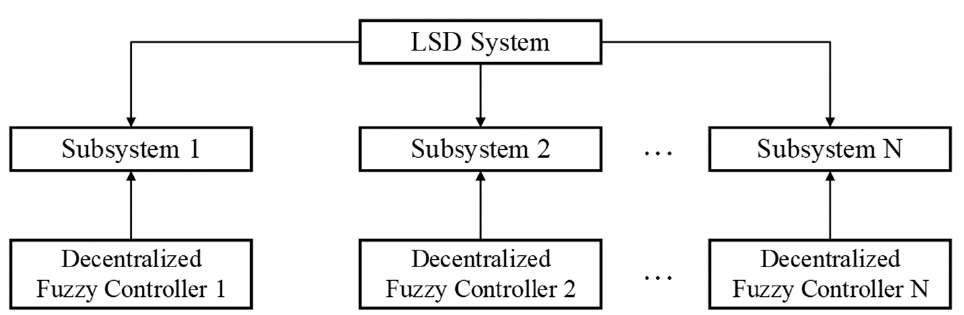
Figure 1. Decentralized control of a nonlinear LSD system.